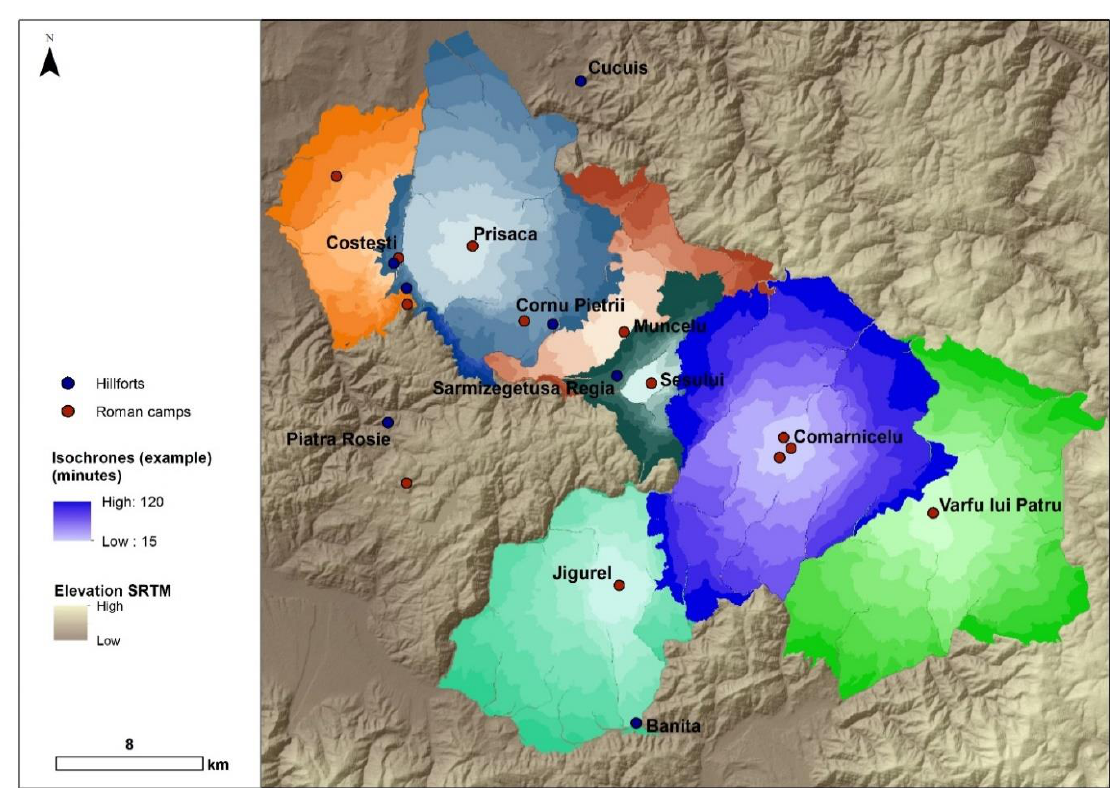
Figure 10. General distribution of isochrones indicating the area of reach within up to 2 h on foot from Roman army bases in the Orăştiei Mountains.